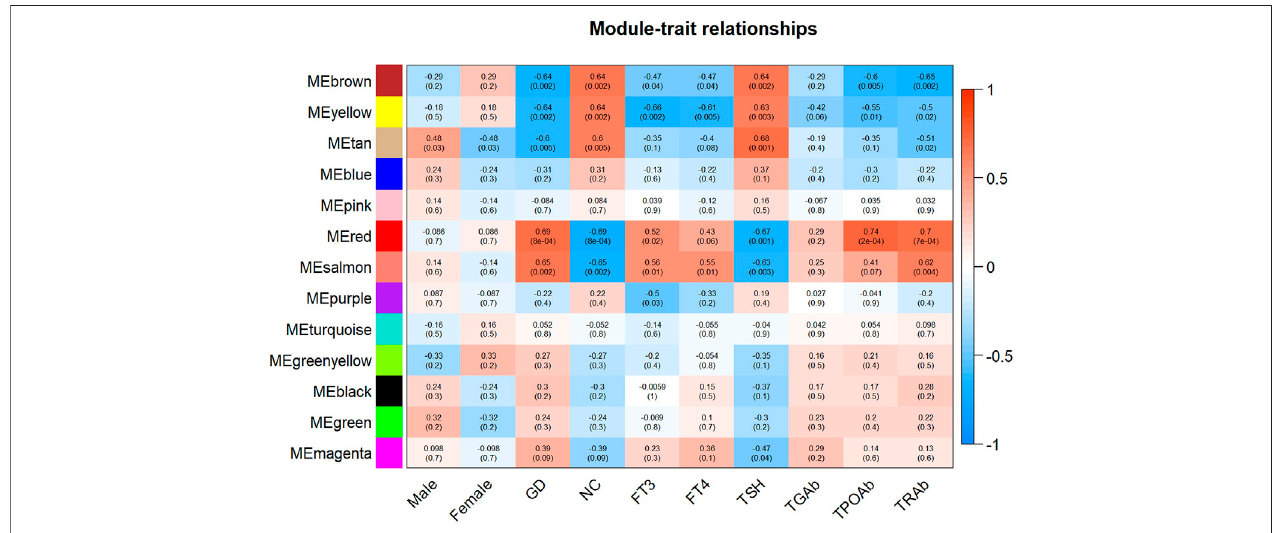
FIGURE 4 | Heatmap of the correlation between each coexpression module and relapsed GD and different phenotypes. The phenotypes mainly include sex, FT3, FT4, TSH, TGAb, TPOAb, and TRAb. (The correlation coef fi cient and corresponding p value were shown in each cell.)